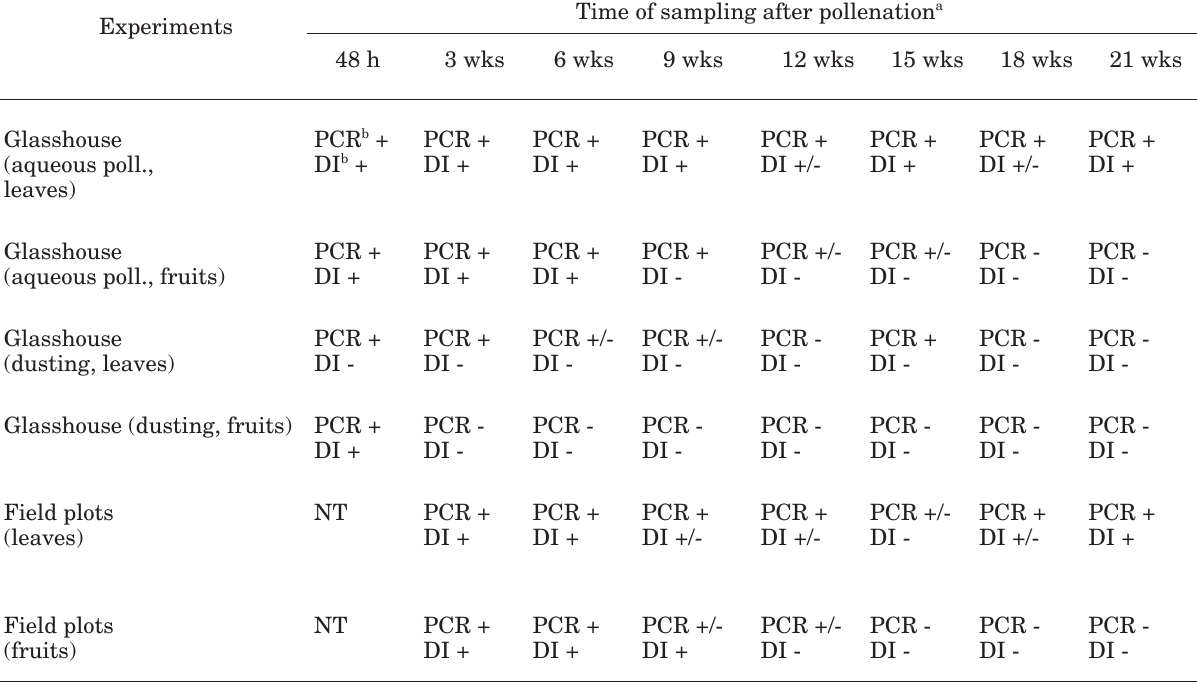
Table 1. Detection of epiphytic populations of Pseudomonas syringae pv. actinidiae (Psa) in glasshouse experiments and in commercial orchards, where the pathogen was applied in different pollen